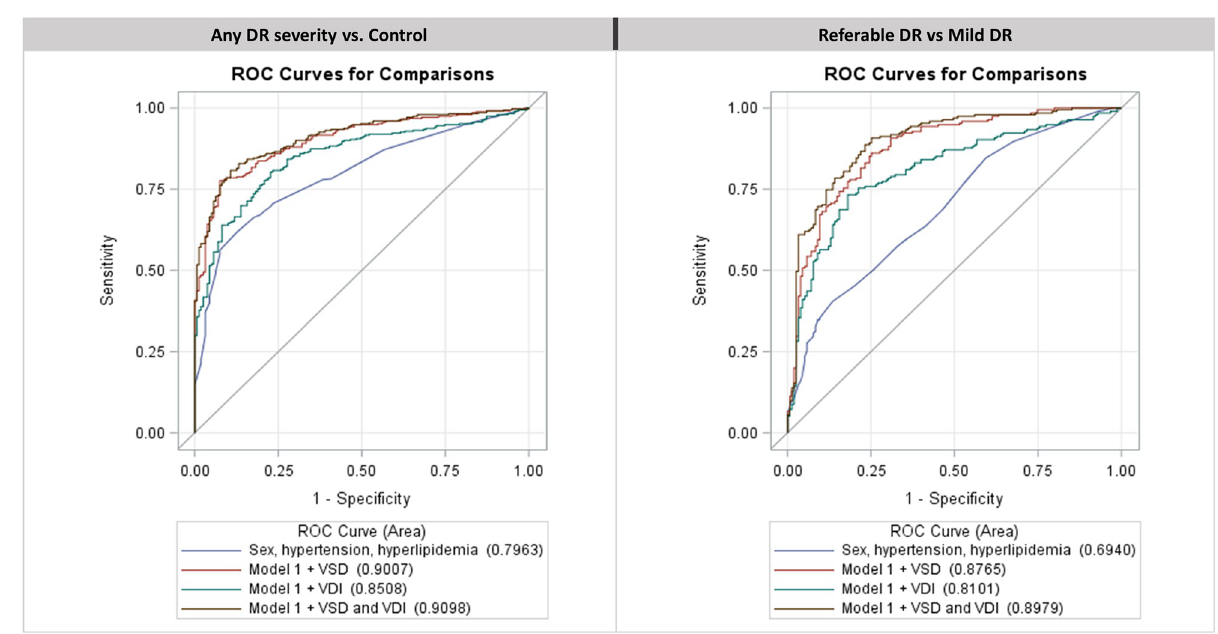
Fig 2. Receiver operator characteristic (ROC) curves. ROC curves for the constrained comparisons of any DR severity versus control and referable DR versus mild non-proliferative DR in Cohort 1. Additional lines are drawn for the sequential addition of VSD and VDI as parameters to the baseline model (labeled Model 1 and drawn in blue) containing sex, hypertension, and hyperlipidemia. A red line is drawn for a model with the parameters for Model 1 with VSD (red), a green line is drawn for a model with the parameters of Model 1 with VDI (green), and a brown line is drawn for the complete model containing the parameters of Model 1 with VSD and VDI (brown). Area under the curve for each ROC curve is listed in parenthesis next to each model in the legend.